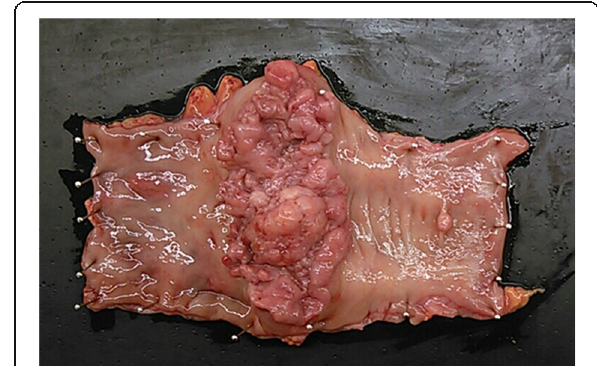
Fig. 5 The specimen was a circumferential tumor measuring 90 × 40 mm. The mucosa except for the tumor of the specimen had no evidence of colitis